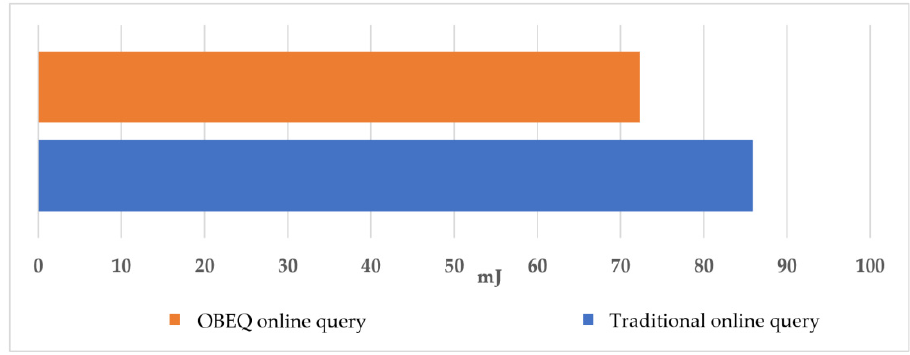
Figure 17. The power consumption of SUM aggregation.